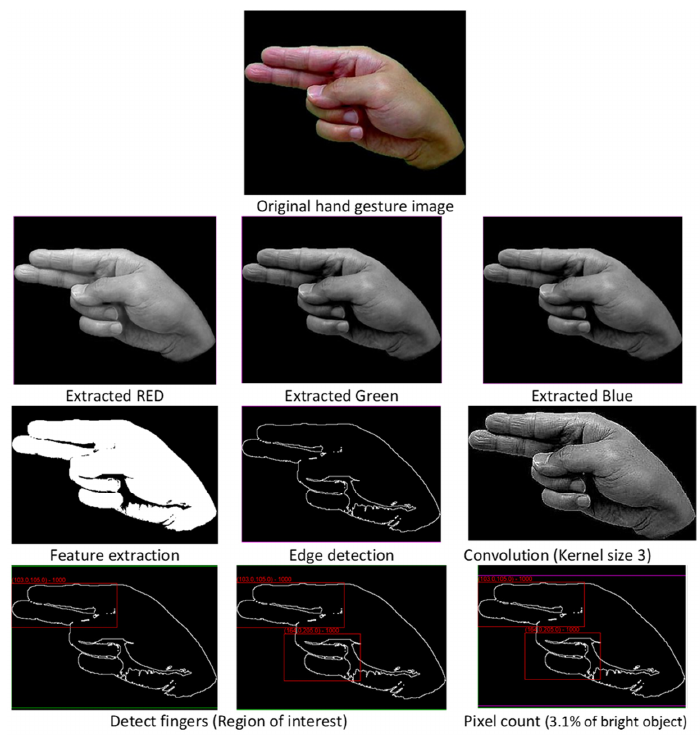
Figure 6. Examples of processed images using the ML algorithm.